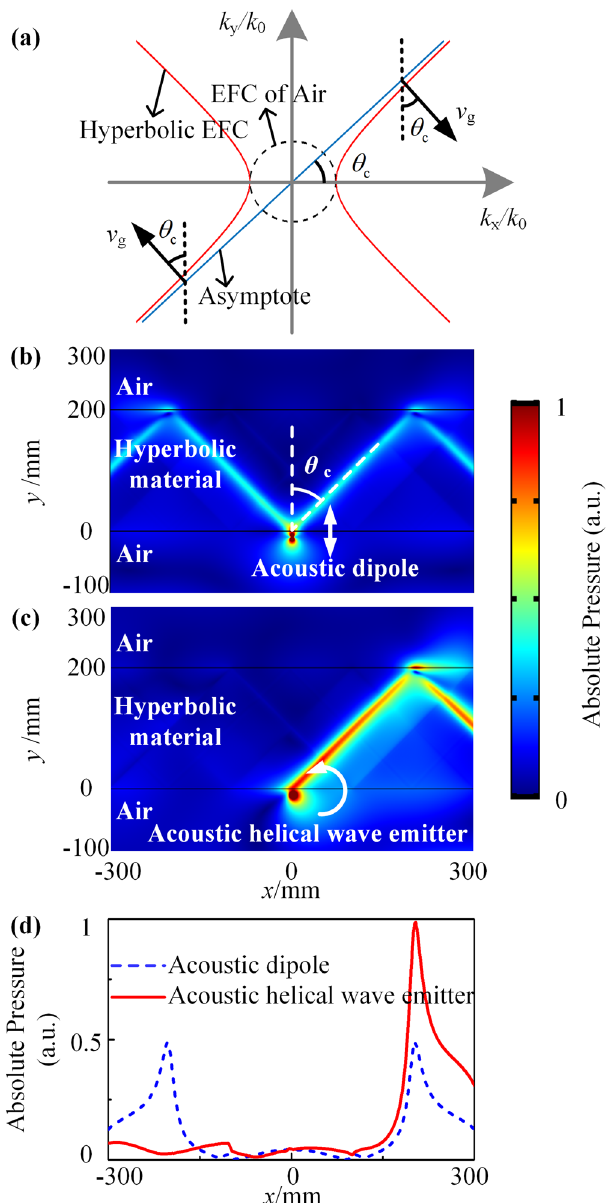
Figure 1. (a) Equifrequency contour of k x − k y plot in the AHMM with hyperbolic dispersion ( ρ x = 1.39 kg/m 3 , = − 1.39 kg/m 3 , K = 152 KPa). Absolute pressure distribution of (b) acoustic dipole and (c) acoustic helical ρ y wave emitter radiating in the vicinity (at 10 mm distance from the interface) of an AHMM slab sandwiched by air (See Supplementary Movie 1 for dynamic view). (d) Absolute pressure along the cutline y = 200 mm of (b) and (c)